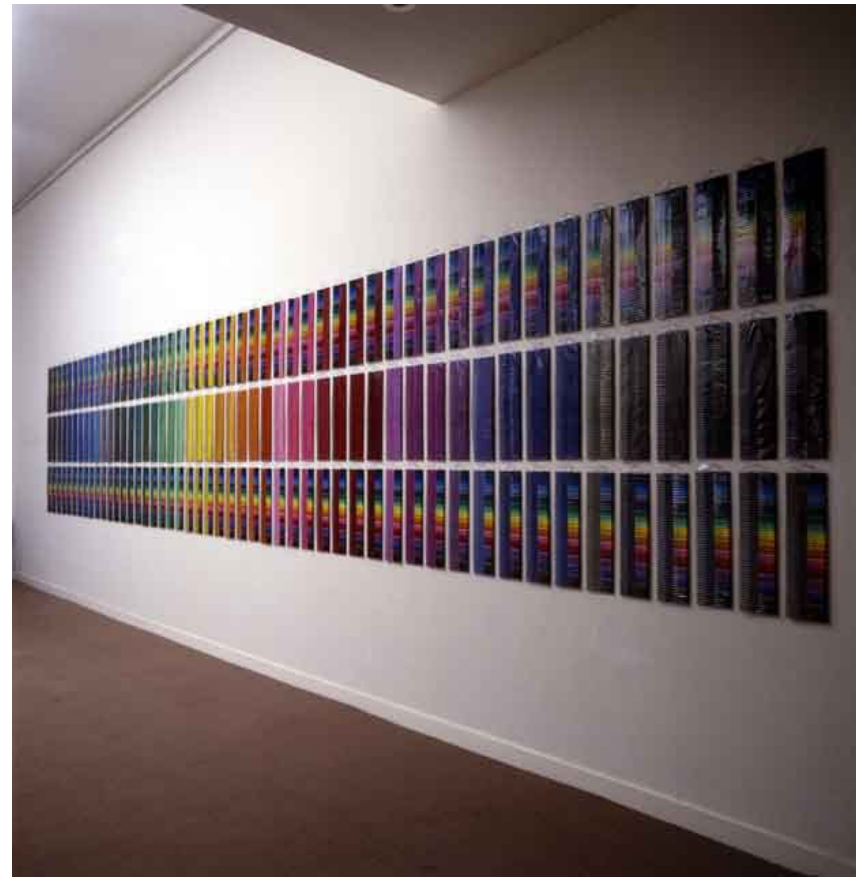
Figure 3: Rob Scholte: Made in China.